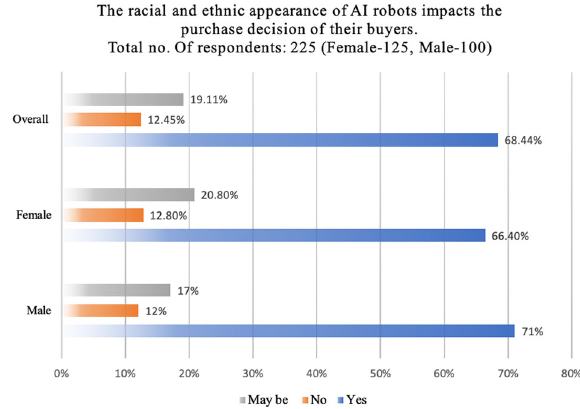
Fig. 2 AI robots may endanger human existence and lead to a society that is increasingly prejudiced, discriminatory, and solitary. Total no. of respondents: 225 (Female: 125, Male: 100).